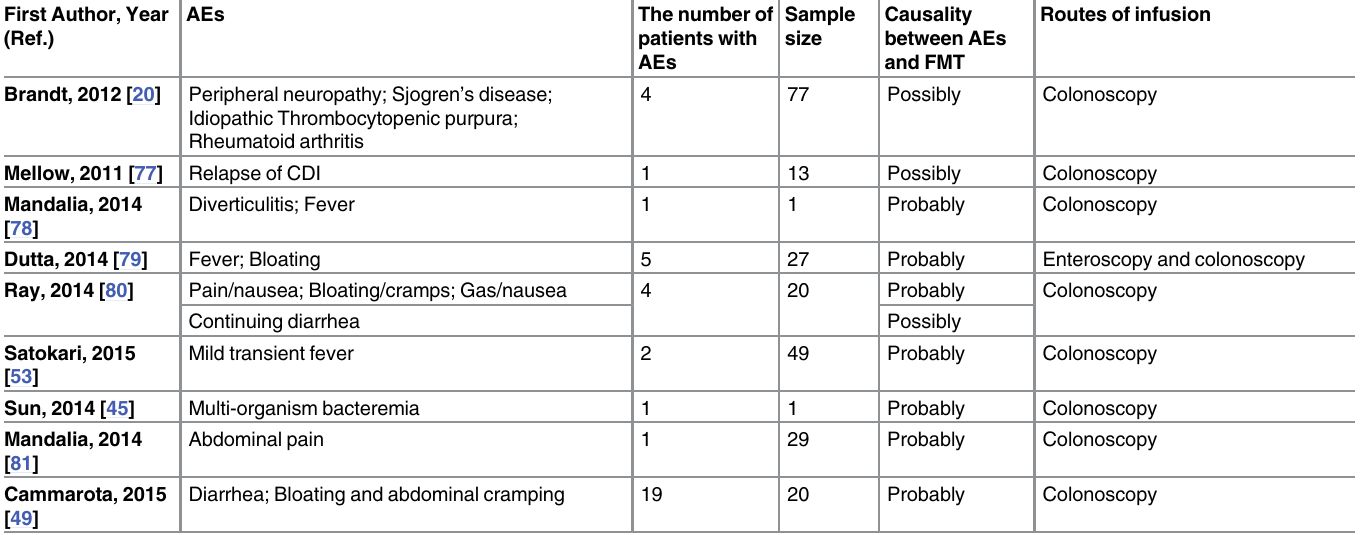
routes of administration, lower gastrointestinal routes include colonoscopy, sigmoidoscopy and retention enema. Upper gastrointestinal routes include the remaining means. Compared with upper gastrointestinal routes, lower gastrointestinal routes were more widely used. After exclusion of the publications in which the routes of administration were not clearly stated, the proportion of patients affected by FMT-attributable AE is 43.6% (89/204) for upper gastrointestinal routes of FMT administration, while the incidence dropped to 17.7% (76/430) for lower gastrointestinal routes. The FMT-attributable AEs were grouped by routes of administration (Tables 2 and 3). Among the 78 kinds of AEs, 5 kinds were definitely related to endoscopic manipulation. Of these, nasal stuffiness, sore throat, rhinorrhea and upper gastrointestinal hemorrhage hap- pened on a total of 8 patients in 4 publications, which were attributable to upper gastrointesti- nal routes administration. It seems that patients are likely to be injured by invasive endoscope procedures for upper gastrointestinal routes of FMT administration. The commonest attributable AE was abdominal discomfort for both upper and lower gas- trointestinal routes, including abdominal pain, increased stool frequency, flatulence, bloating, cramps and other nonspecific symptoms. For upper gastrointestinal routes of administration in 12 publications, 29.9% (61/204) patients (in 9 publications) were reported to suffer abdomi- nal discomfort after FMT. For lower gastrointestinal routes in 22 publications, 13.0% (56/430) patients (in 10 publications) developed abdominal discomfort after FMT. The upper gastroin- testinal routes were therefore more likely to develop abdominal discomfort compared with lower gastrointestinal. The second commonest attributable AE was transient fever which was happened on 3.4% (7/204) and 2.8% (12/430) patients for upper and lower gastrointestinal routes of FMT administration, respectively (Table